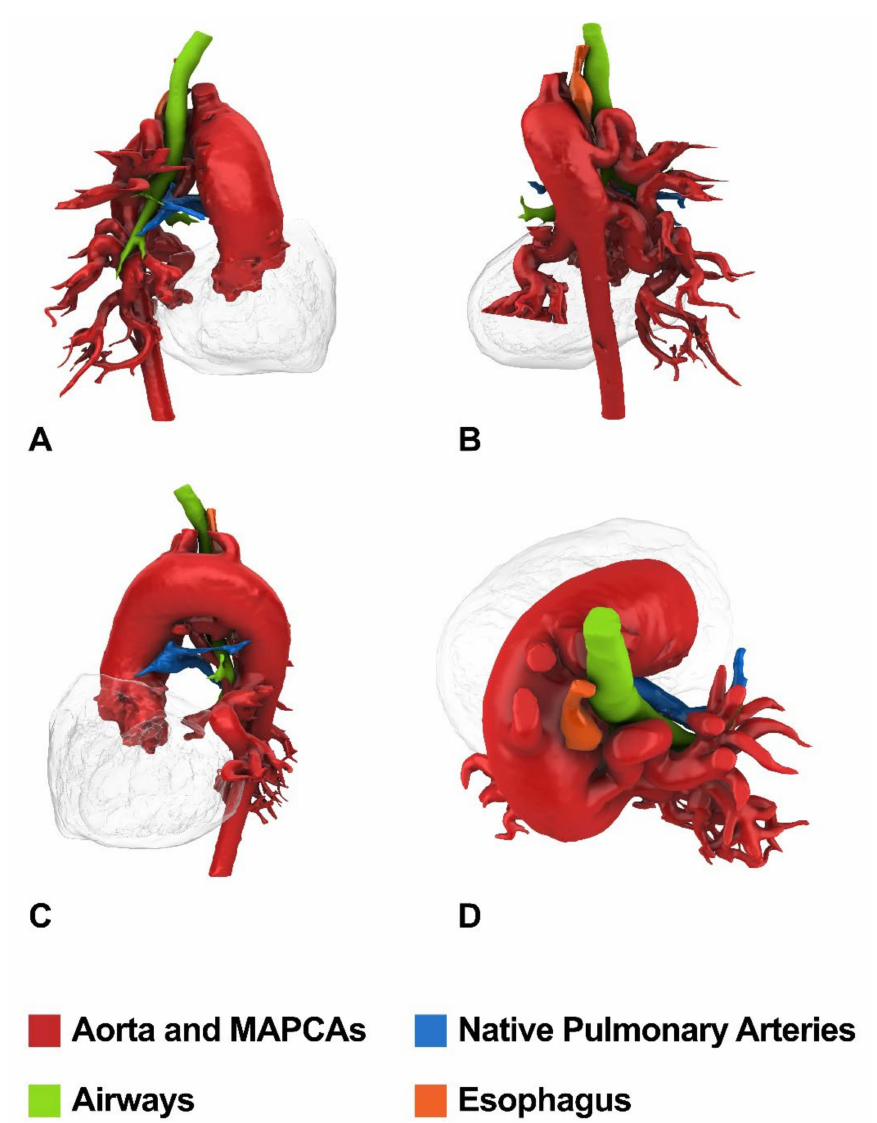
Figure 5. Preoperative CT imaging of the patient who underwent one-stage unifocalization and repair. Colored rendering for Frontal ( A ), Posterior ( B ), Lateral ( C ), and Top ( D ) views obtained from CT images with semi-automatic 3D segmentation